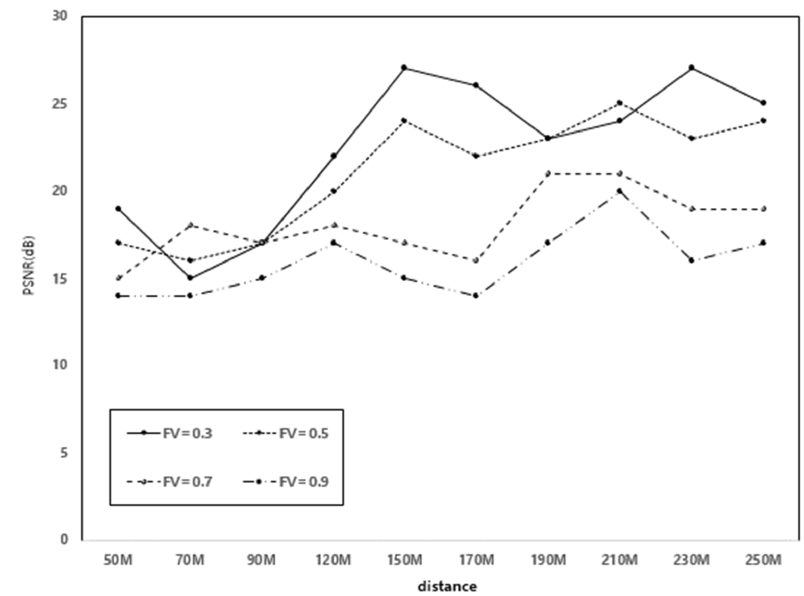
Figure 9. PSNR with distance.